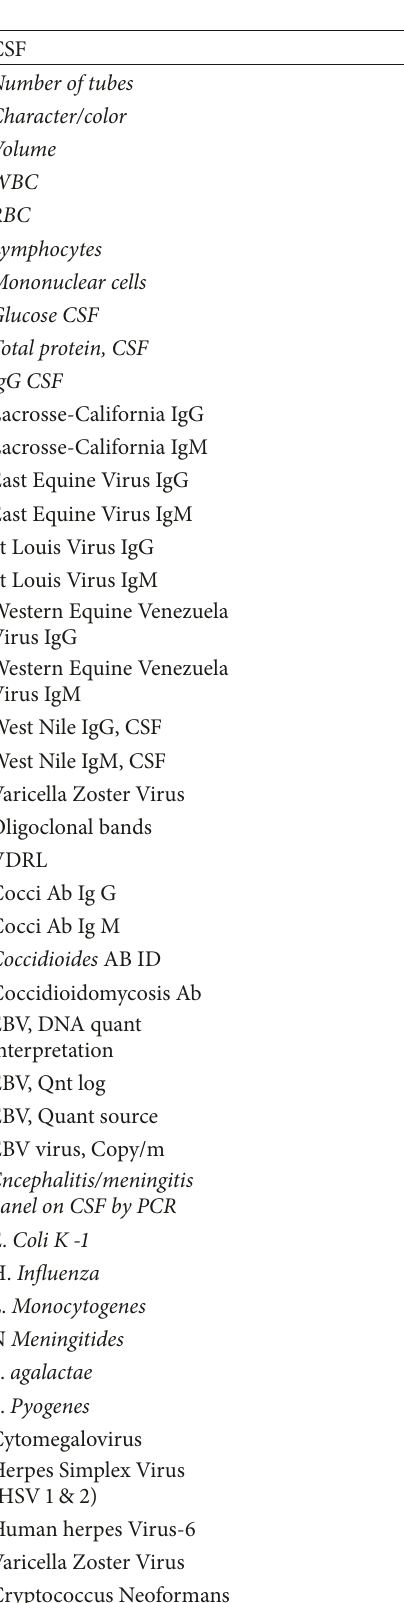
Table 2: Cerebrospinal fluid